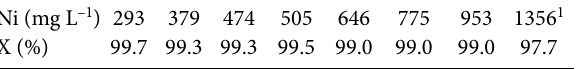
Table 3. Efficiency of nickel removal by electrocoagulation